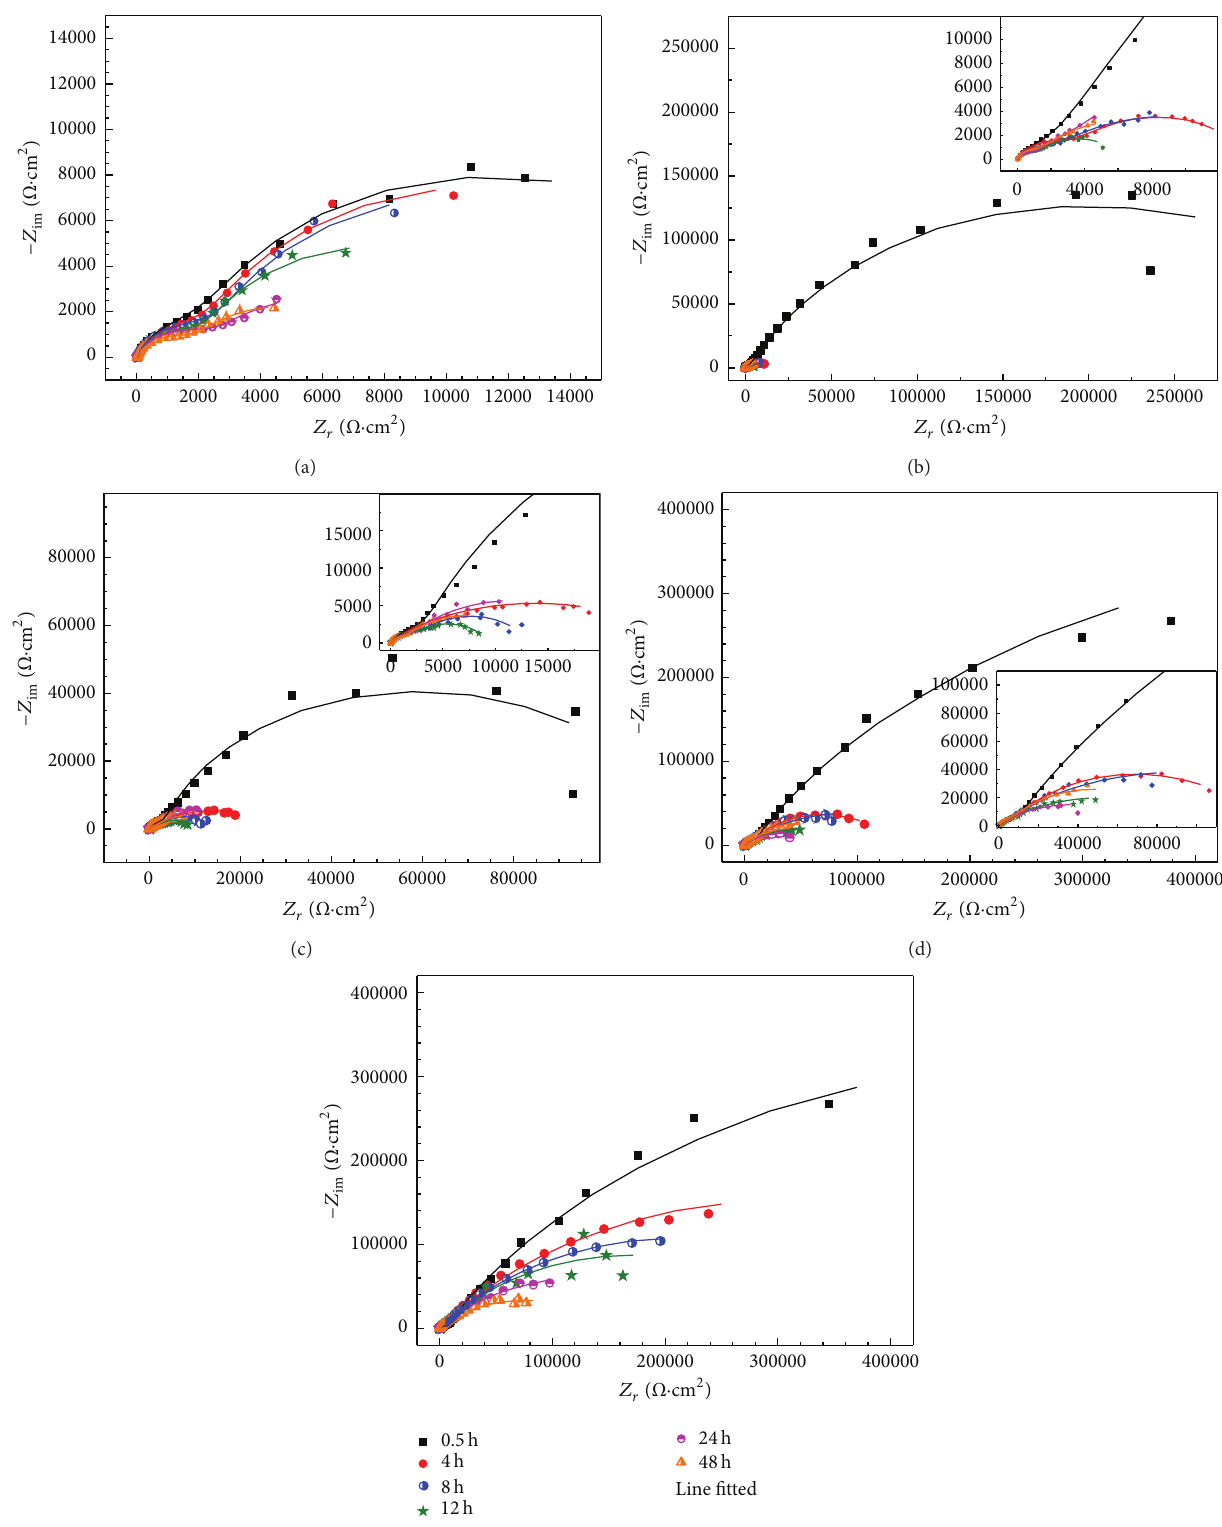
Figure 11: Nyquist diagrams for 2A12 aluminum alloy substrate (a) and specimens after exposure for 1 month (b), 6 months (c), 12 months (d), and 24 months (e) during the immersion